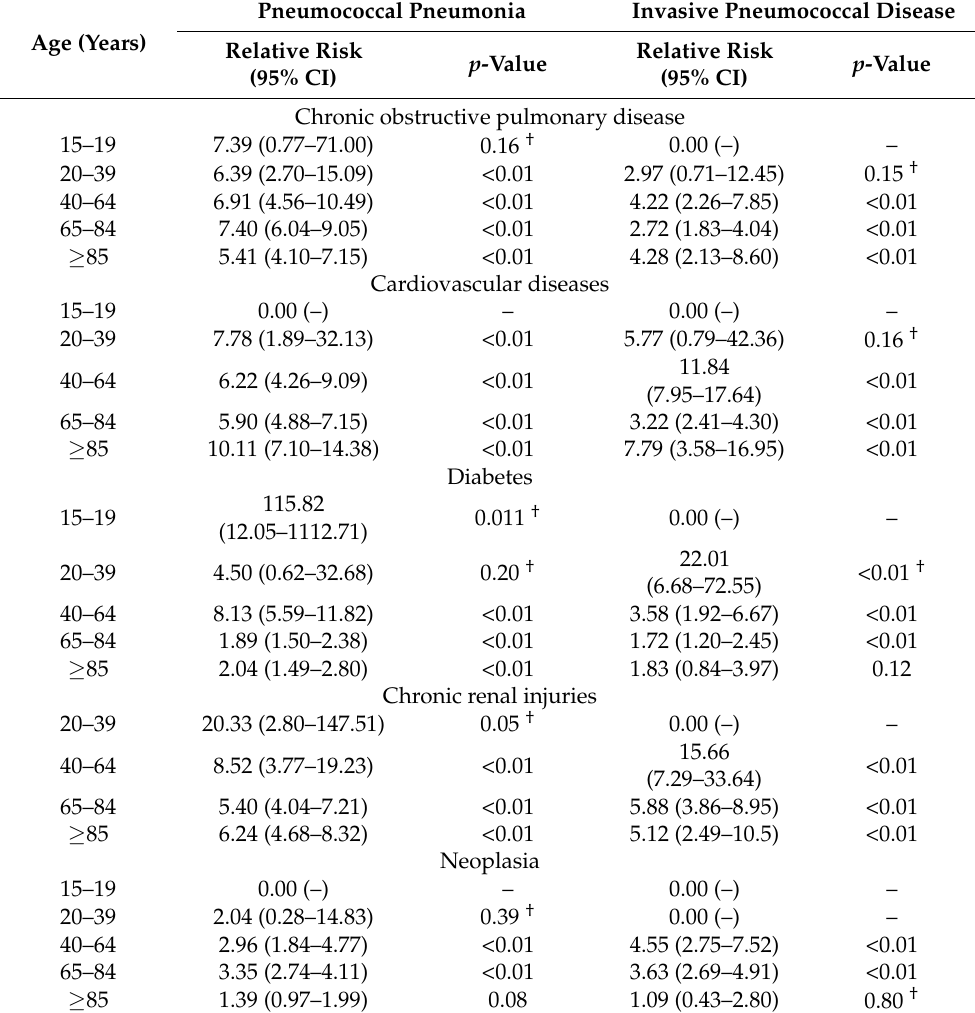
Table 5. Relative risk of comorbidities of pneumococcal pneumonia and IPD in adolescents and adults ≥ 15 years of age in Liguria, Italy